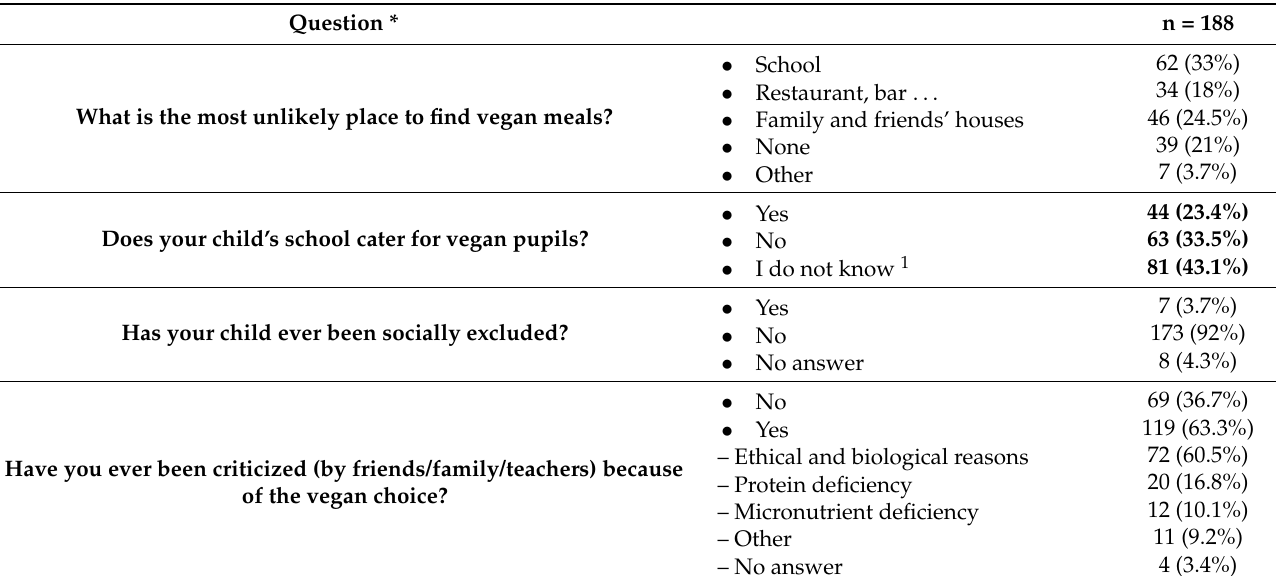
Table 5. Parents’ answers to questions aimed at evaluating some issues encountered in implementing a VD for their children in everyday